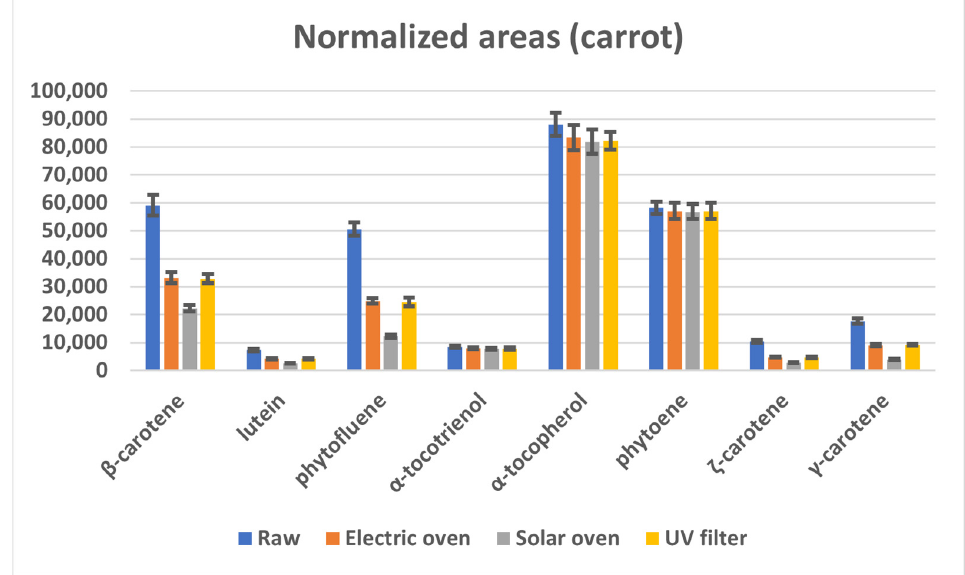
Figure 2. Mean chromatographic areas normalized for the weight of the sample, obtained from the HPLC-MS analyses of raw carrot samples (blue series) and after cooking by electric oven (orange series), solar oven (grey series), and solar oven with UV filter (yellow series).